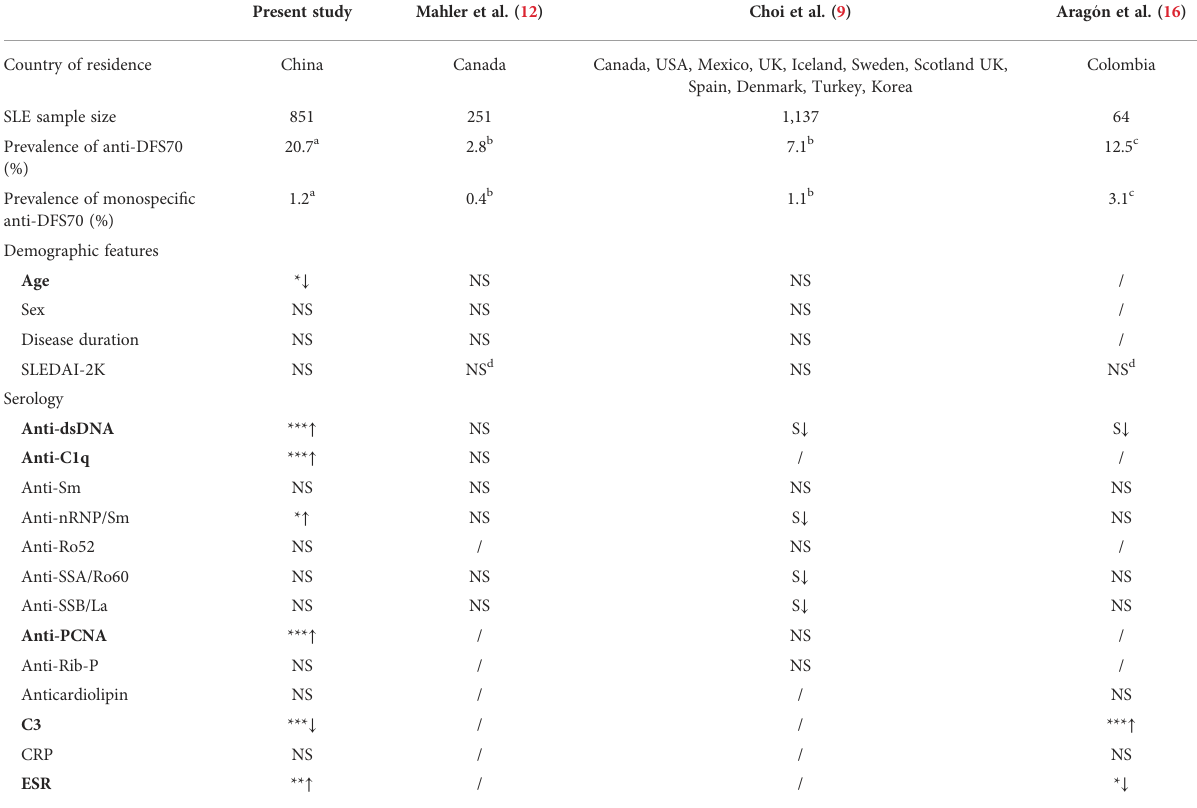
TABLE 4 Comparison of demographic and serological features between anti-DFS70-positive and anti-DFS70-negative adult SLE patients in the present study versus other referral SLE cohorts. Present